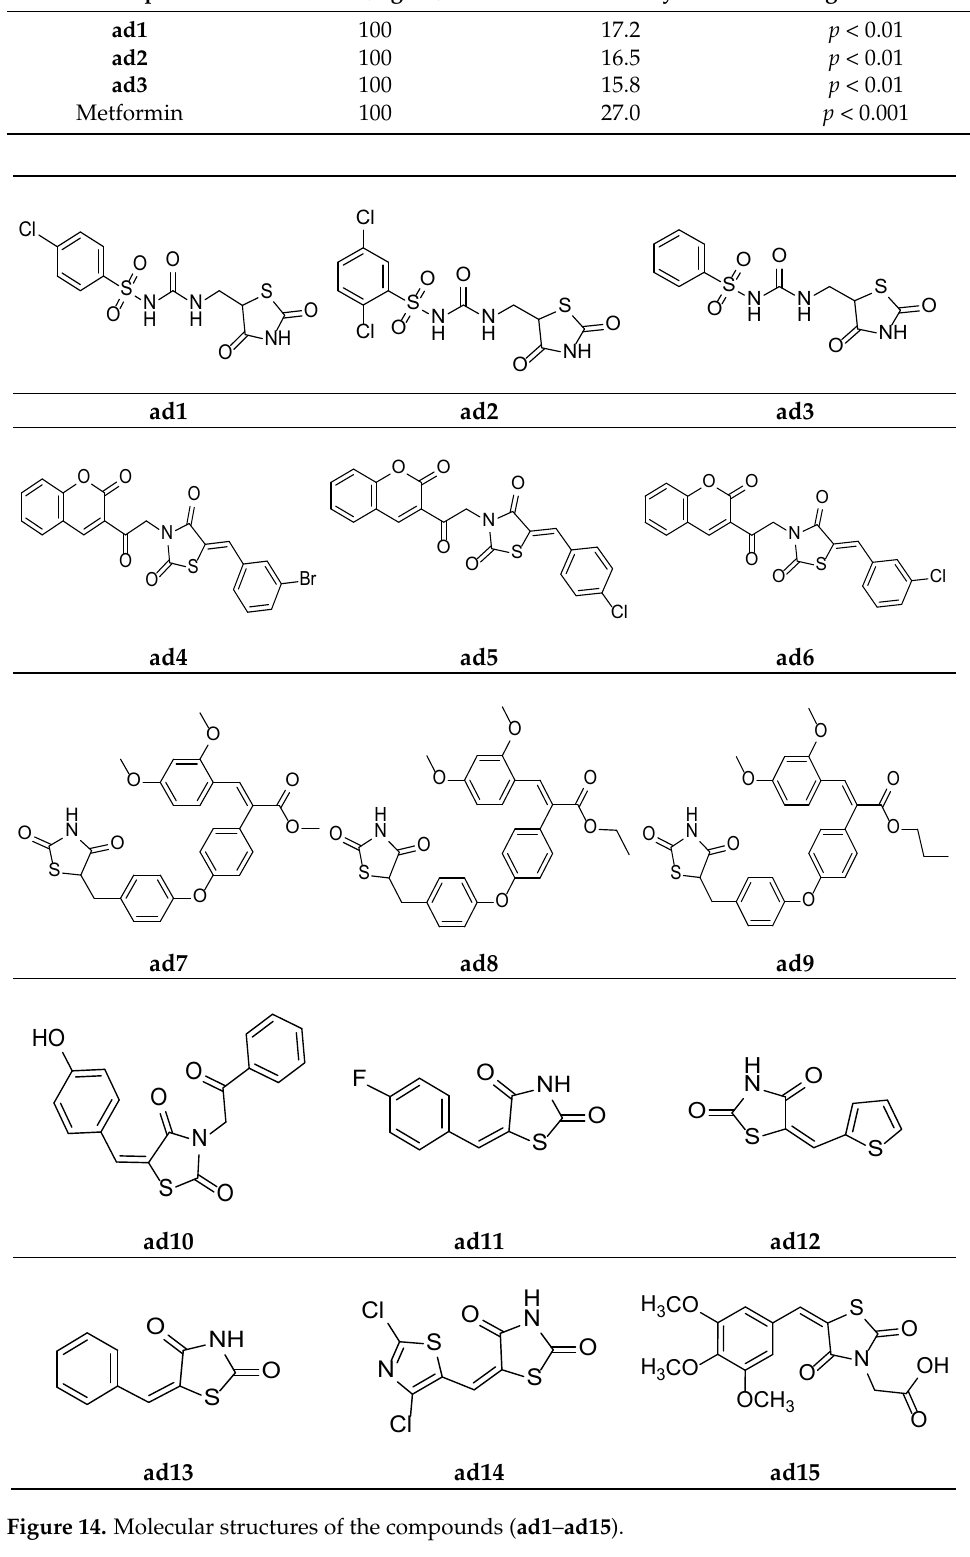
Table 30. Hypoglycemic effect of the compounds ( ad1 – ad3 ) on sucrose-loaded hyperglycemic rats. Comp.